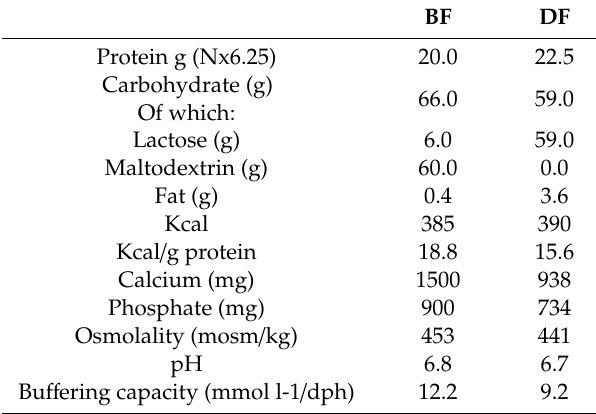
Table 1. Composition of BF and DF; values per 100 g of